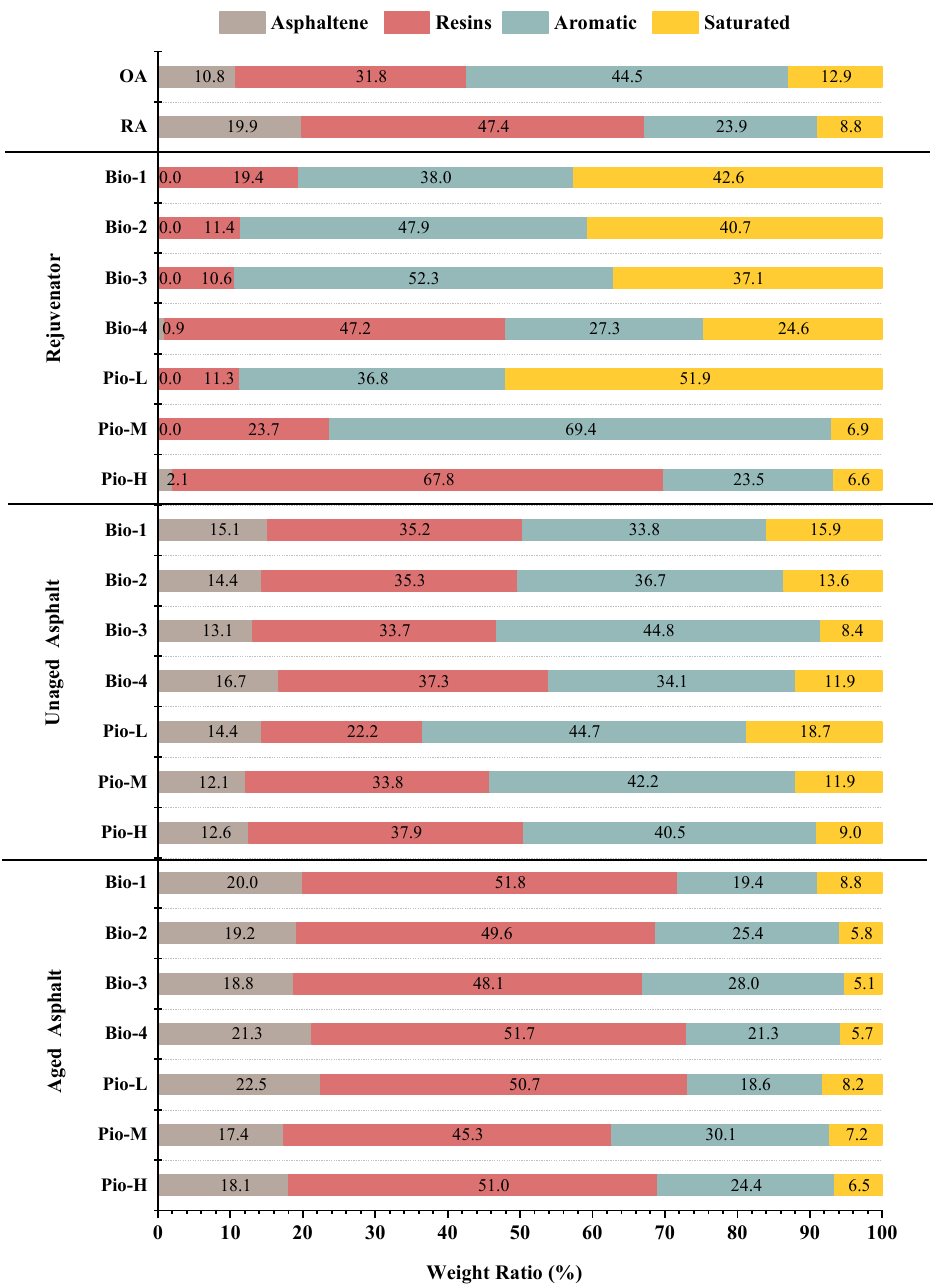
Figure 5. SARA fractions analysis of all the asphalt samples. The subsequent seven bars present the composition of the seven oil-rejuvenators. Considering Bio-1, Bio-2, and Bio-3, the proportion of aromatic increases sequentially, whereas the saturated gradually decreases. Regarding the Bio-4, light and heavy fractions are almost 50/50, and there is even 0.9% asphaltene in them. For the three petroleum-based rejuvenators, the ratio of the heavy fraction increased sequentially from 11.3 for Pio-L to 23.7 for Pio-M and to 69.9% for Pio-H. The fraction composition of rejuvenated asphalt (unaged) is affected by its correspond- ing rejuvenator. Considering the unaged samples (Bio-1 to Bio-3), the proportion of the aromatic increases, whereas the saturated decreases, similar to their corresponding reju- venators. Heavy fractions in the Bio-4 asphalt are also significantly higher than the other three bio-oil-rejuvenated